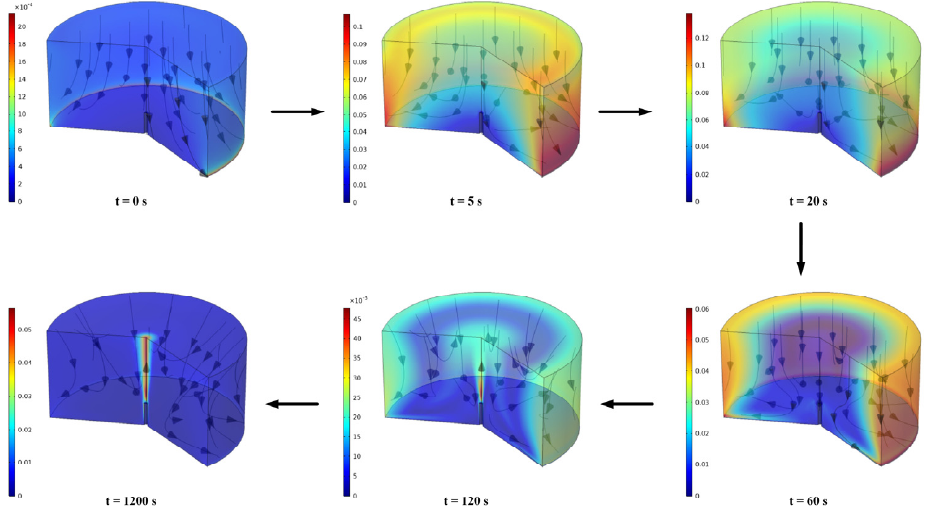
Figure 6. Simulation results for flow velocity field evolution.